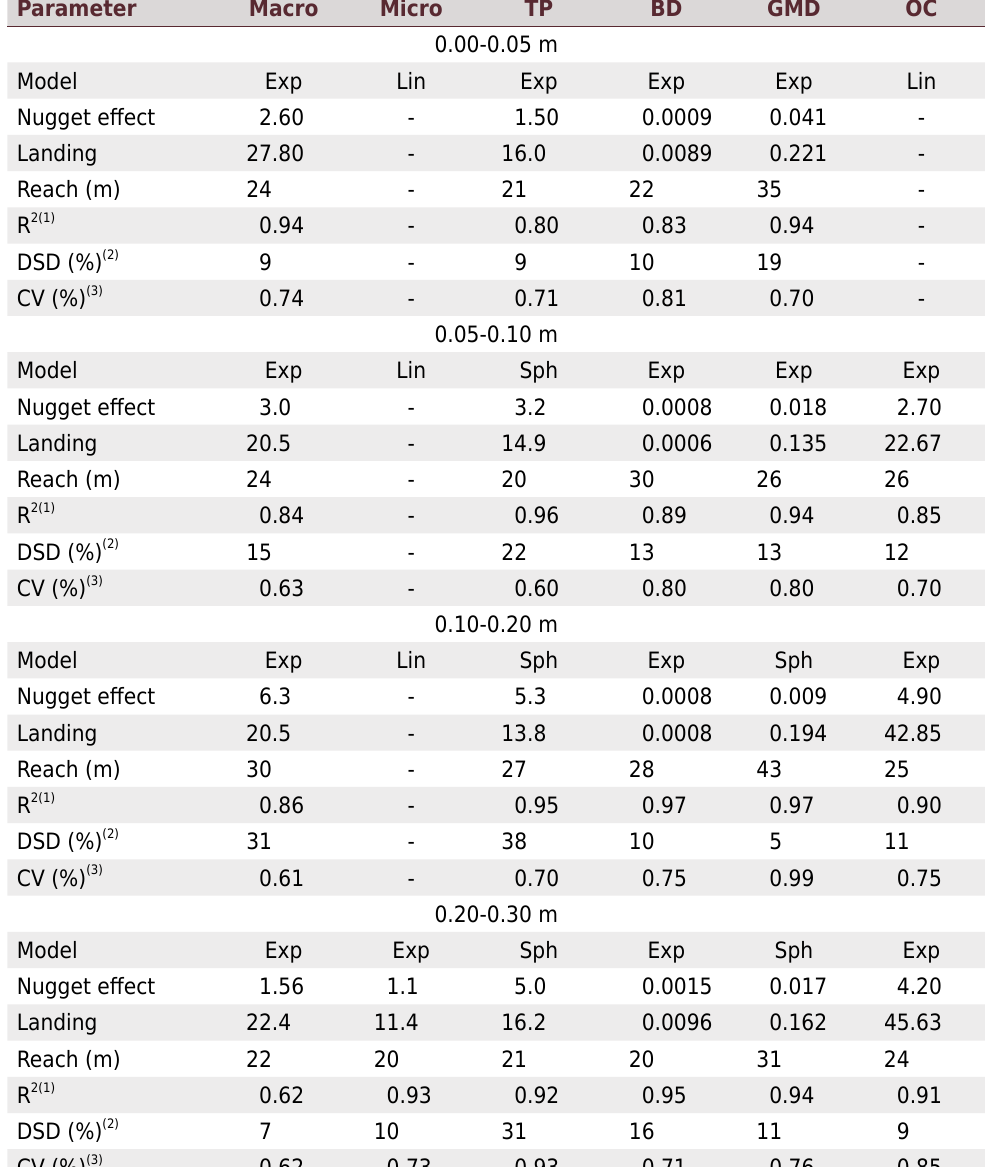
Table 3. Models and estimated parameters for semivariograms of macroporosity (Macro), microporosity (Micro), total porosity (TP), soil bulk density (BD), geometric mean diameter (GMD), and organic carbon (OC), for four soil layers, in soils from areas of Archaeological Dark Earth under cacao cultivation